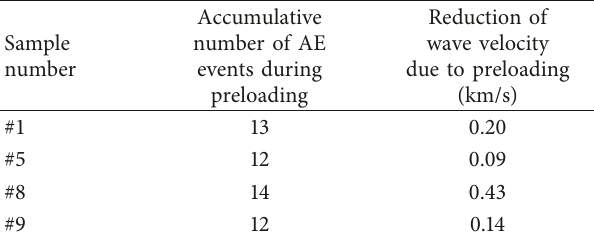
Figure 3: Location map of acoustic emission events. (a) Location map for the initial damage events of rock sample #1; (b) location map for the initial damage events of rock sample #5; (c) location map for the initial damage events of rock sample #8; (d) location map for the initial damage events of rock sample #9. Table 2: AE events and reduction of the wave velocity due to